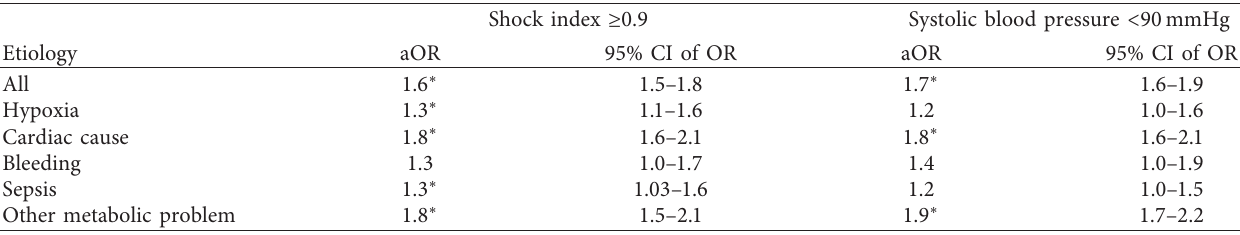
Figure 2: (a) Survival analysis of patients with shock index ≥ 0.9 and < 0.9. (b) Survival analysis of patients with systolic blood pressure < 90mmHg and ≥ 90mmHg. Table 2: The association between in-hospital 30-day mortality and shock index ≥ 0.9 and blood pressure < 90mmHg in different etiologies of cardiac